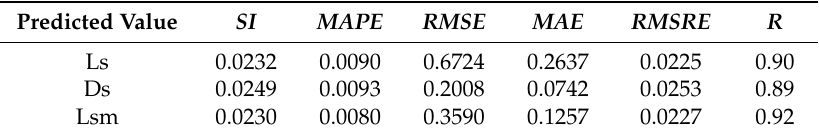
Table 4. The statistical performance of ELM models during validation period in prediction of Ls, Ds and Lsm using non-dimensional